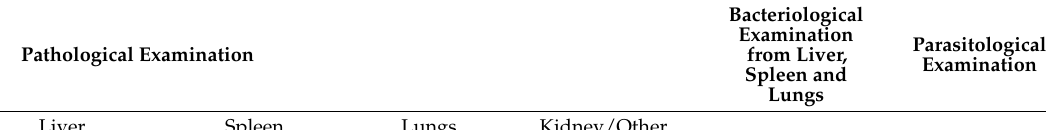
Table 5. Necropsy, bacteriological and parasitological data from hares and